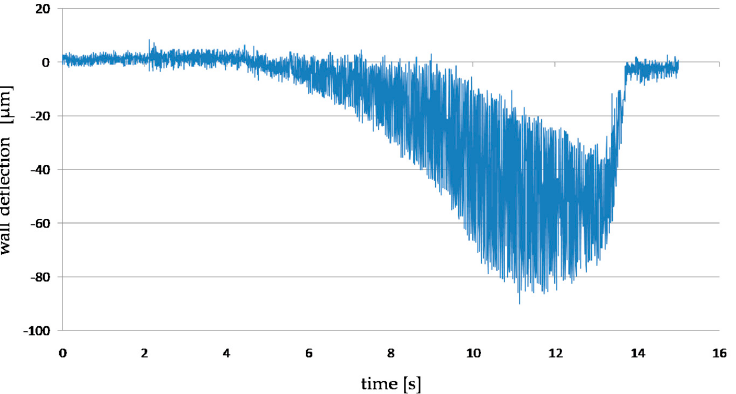
Figure 6. The plot of the deflection of the thin-walled workpiece obtained by measuring the deformation with a displacement laser sensor.